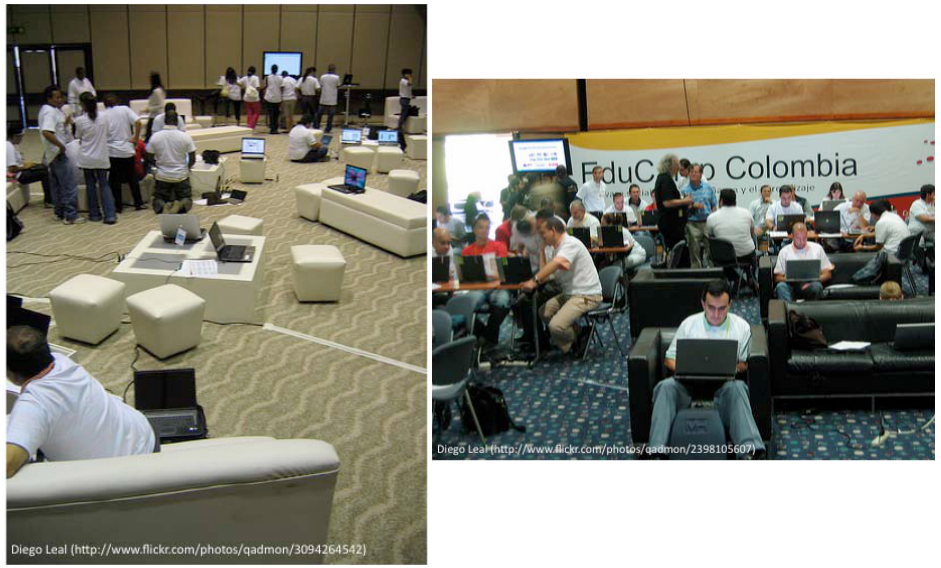
Figure 3. Examples of furniture and